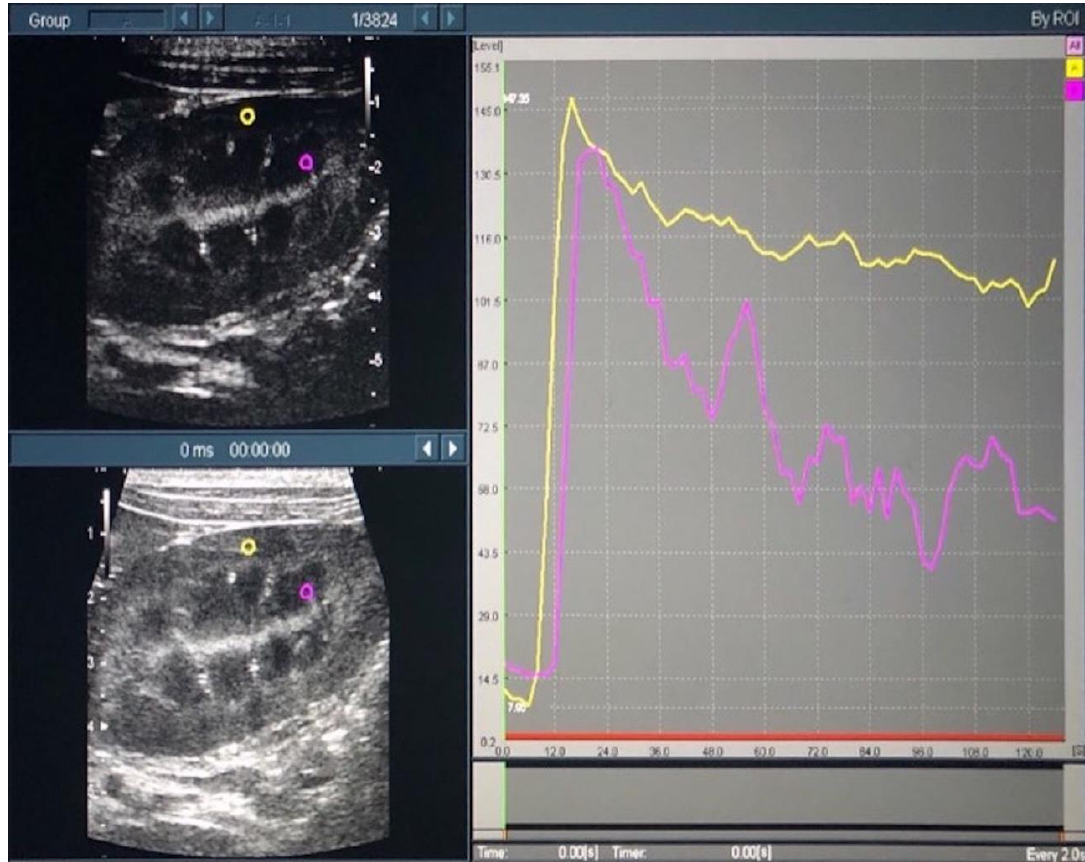
Figure 2. Time intensity curves of the renal cortex and medulla in contrast-enhanced ultrasonography. In the left figure, the yellow and purple circles indicate the regions of interest in the cortical and medullary regions, respectively. In the right figure, the yellow and purple lines indicate the time intensity curves in the cortical and medullary regions, respectively.